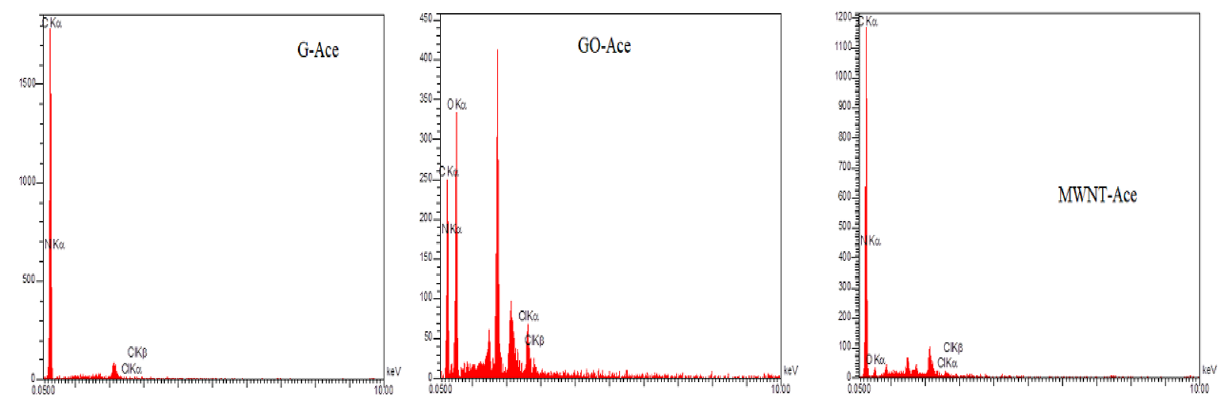
Figure 10. EDS of adsorption of